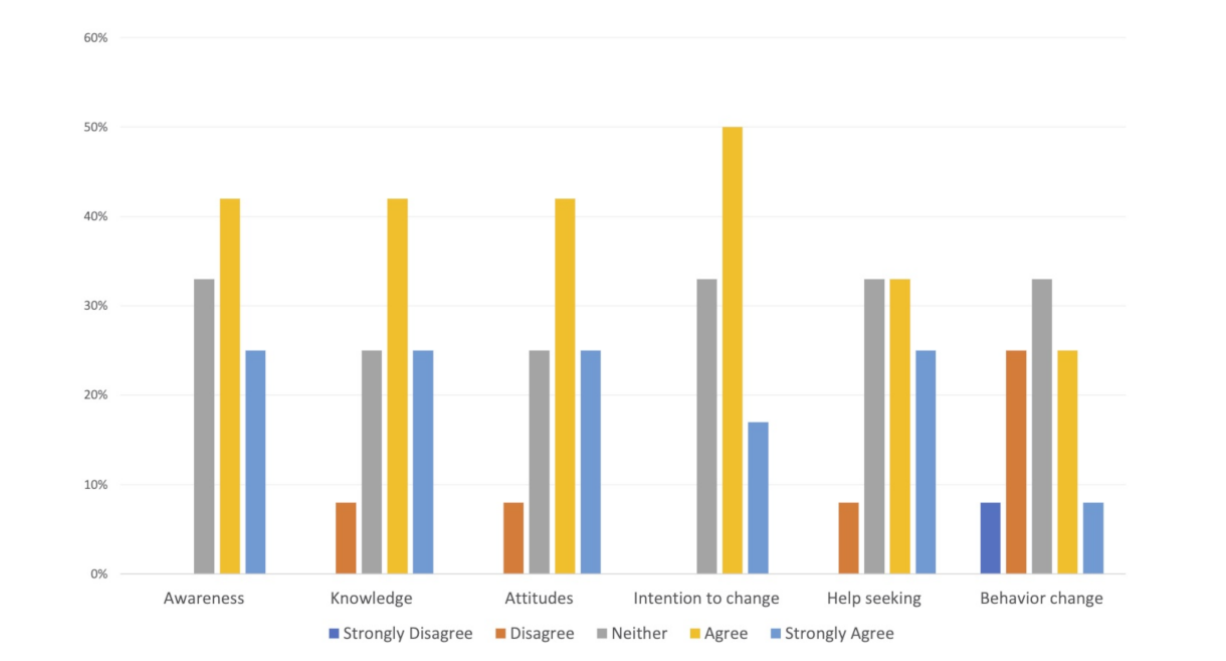
Figure 3. Impact of App Usage on Mental Health Knowledge and